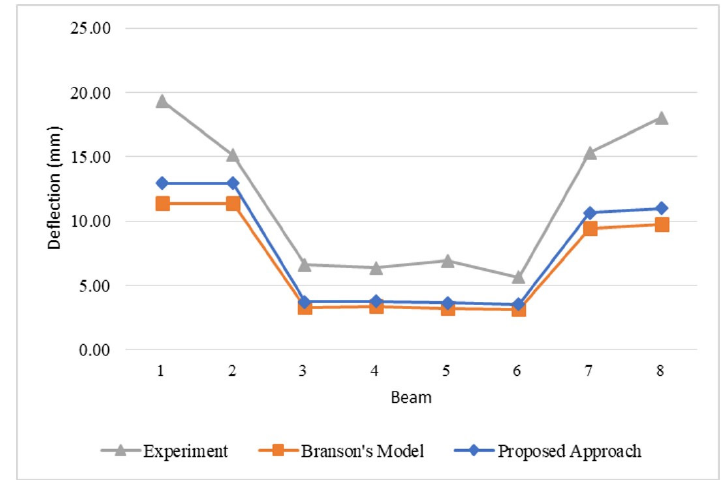
Figure 13. Beams with reinforcement rate greater than 3%.